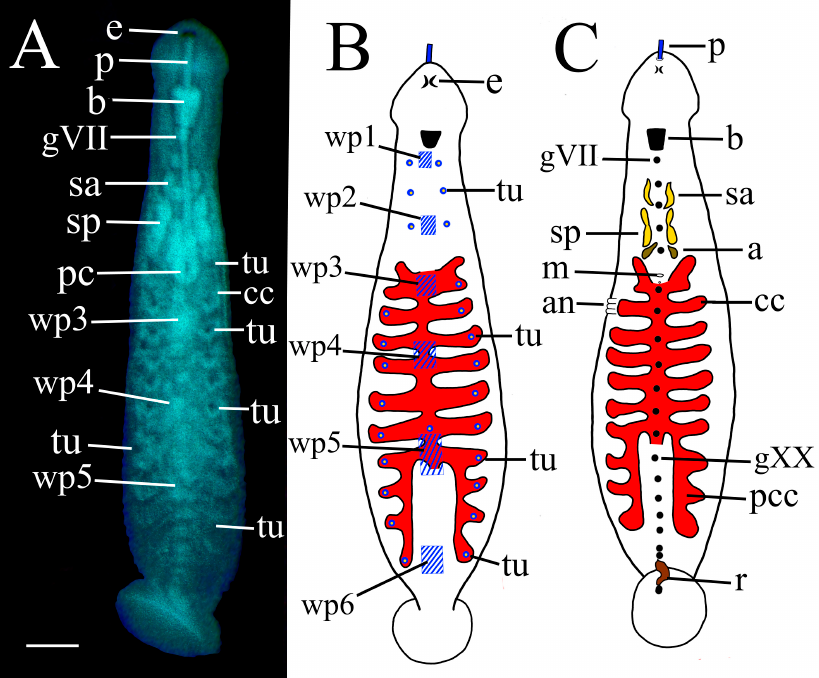
Figure 12. Six white pigment patches (wp) and metameric dorsal tubercles (tu) are clearly manifest in the hatchling of P. parasitica , but are barely perceptible in the adult. Shown are ( A ) photomicrograph of a typical hatchling offspring of PP ‐ 4a (dorsal view); ( B ) composite scheme based on several hatchlings, dorsal view; and ( C ) composite scheme, ventral view. Abbreviations: a, atrium; an, annuli a1, a2 and a3 of segment XIV; b, brain; cc, crop caecum; e, eye; gVII, ganglion VII; gXX, ganglion XX; m, male gonopore; p, proboscis; pc, proboscis crook; pcc, posterior crop caecum; r, rectum; sa, anterior salivary gland; sp, posterior salivary gland; tu, tubercle; wp1–wp6, white patch 1 to white patch 6. Scale bar: 0.5 mm.